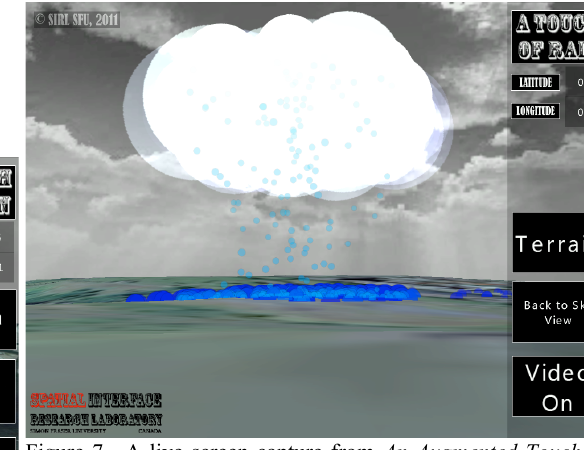
Figure 7. A live screen capture from An Augmented Touch of Rain – showing the user’s situated virtual world view. The other way the user can view and experience the rain simulation, is to view an augmented space . This is the key capability of An Augmented Touch of Rain. After creating the cloud and rain systems seen in figure 5, and having viewed the situated virtual environment mode (figure 6 and 7), our interface allows the user to selectively toggle components of the virtual world on and off. This results in views that combine real and virtual objects – otherwise known as a ‘mixed reality’ scene (Milgram and Kishino, 1994). Figure 8 shows a scene from our field testing - with real sky and trees combined with a virtual cloud, virtual rainstorm, and virtual land surface (registered to real